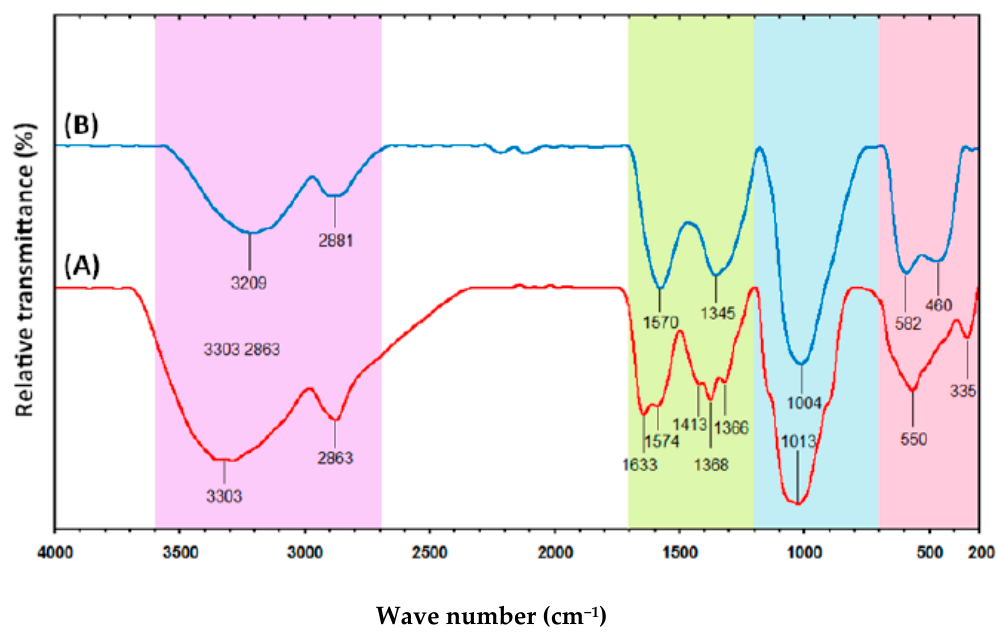
Figure 9. XRD patterns of PS, CuNPs and CuNPs / PS composites [91].